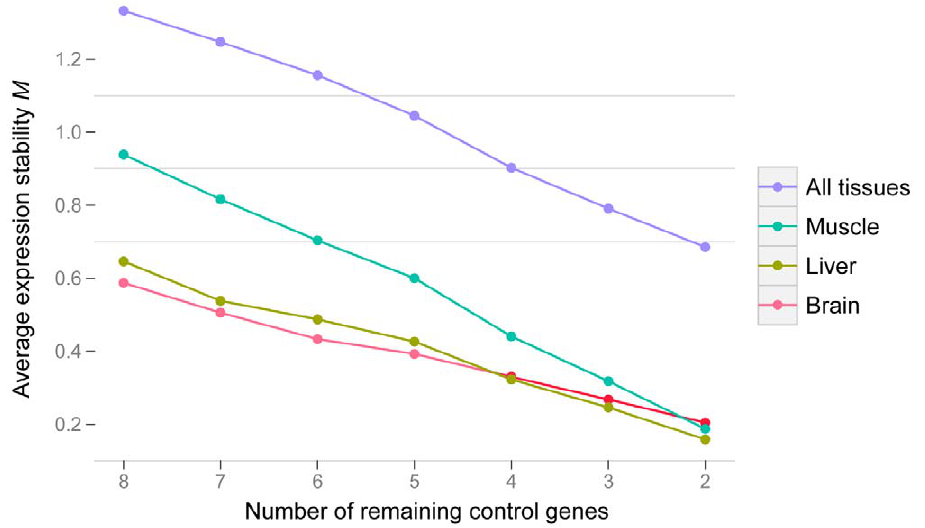
Figure 2. Average expression stability with iterative exclusion of the least stable gene. Low average M values indicate high stability and high average M values indicate less stability.